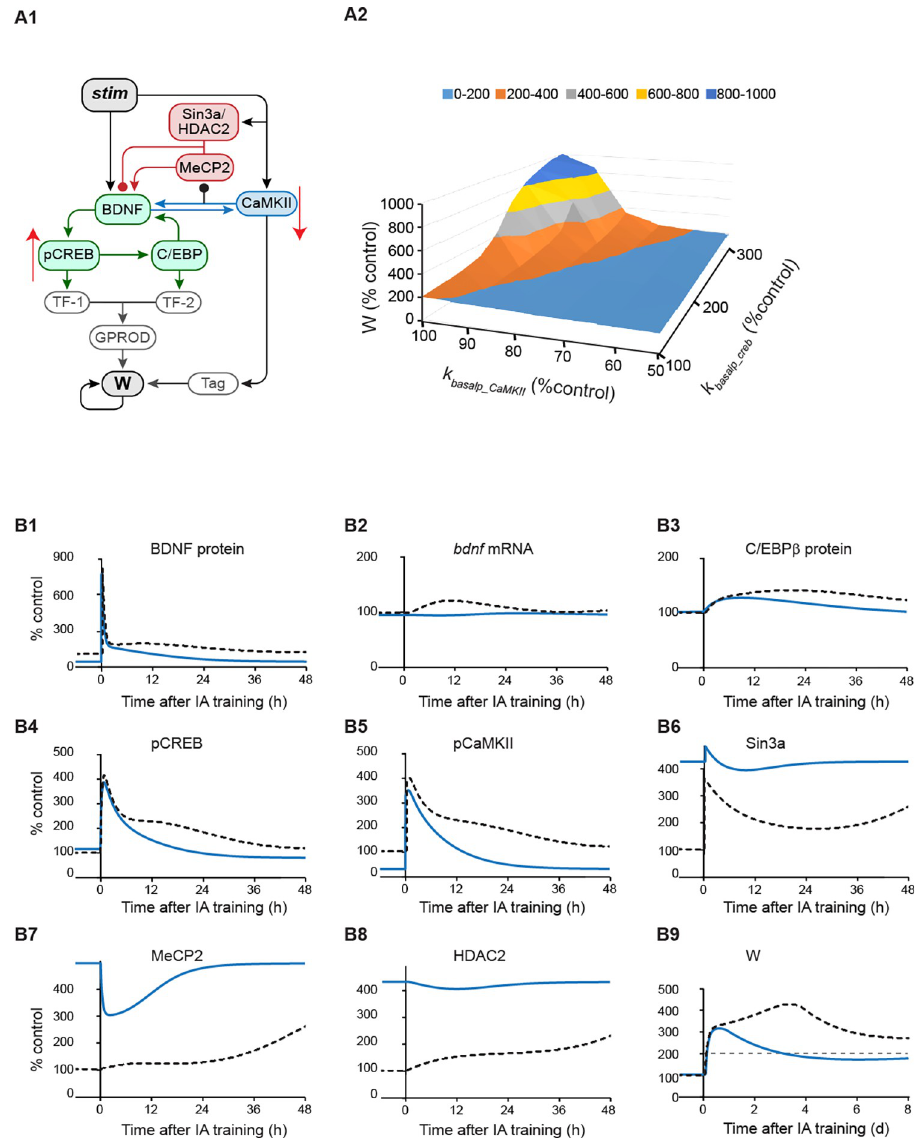
Fig 2. Simulated effects of increased pCREB combined with decreased pCaMKII α on time courses of molecular pathways and synaptic weight W after IA training. (A1) Modifications of the model of the molecular pathways for IA conditioning, including increased basal phosphorylation of CREB, k basalp_creb , concurrent with decreased basal phosphorylation of CaMKII α , k (red arrows). (A2) 3D plot of synaptic weight W at day 7 after training basalp_CaMKII with k basalp_creb increasing from the standard value in Table 1 to 300% of the standard value, and k basalp_CaMKII decreasing from the standard value in Table 1 to 50% of the standard value, with increased binding of MeCP2, Sin3a and HDAC2 (A2). The light blue area represents W less than 200% of basal level. (B) Example of dynamics of BDNF protein/mRNA (B1-2), C/EBP β protein (B3), pCREB (B4), pCaMKII α (B5), Sin3a binding (B6), MeCP2 binding (B7), HDAC2 binding (B8), and W (B9), with the standard parameter values in Table 1 (black dashed) or with k basalp_creb increased by ~50% and k basalp_CaMKII decreased by ~50% from control combined with higher binding levels of MeCP2, Sin3a and HDAC2 (blue) to simulate IA conditioning in infant rats. Gray dashed line in (B9) represents W at 200%